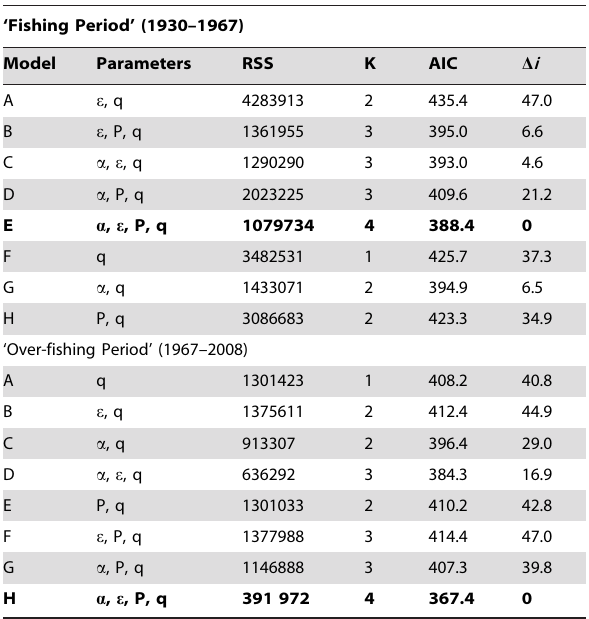
RSS represents the residual sum of squares, K represents the number of parameters while AIC refers to the Aikaike Information Criterion value. Model with the lowest AIC value is indicated in bold. D i is the difference between the AIC value for each model and the model with the lowest AIC value (in